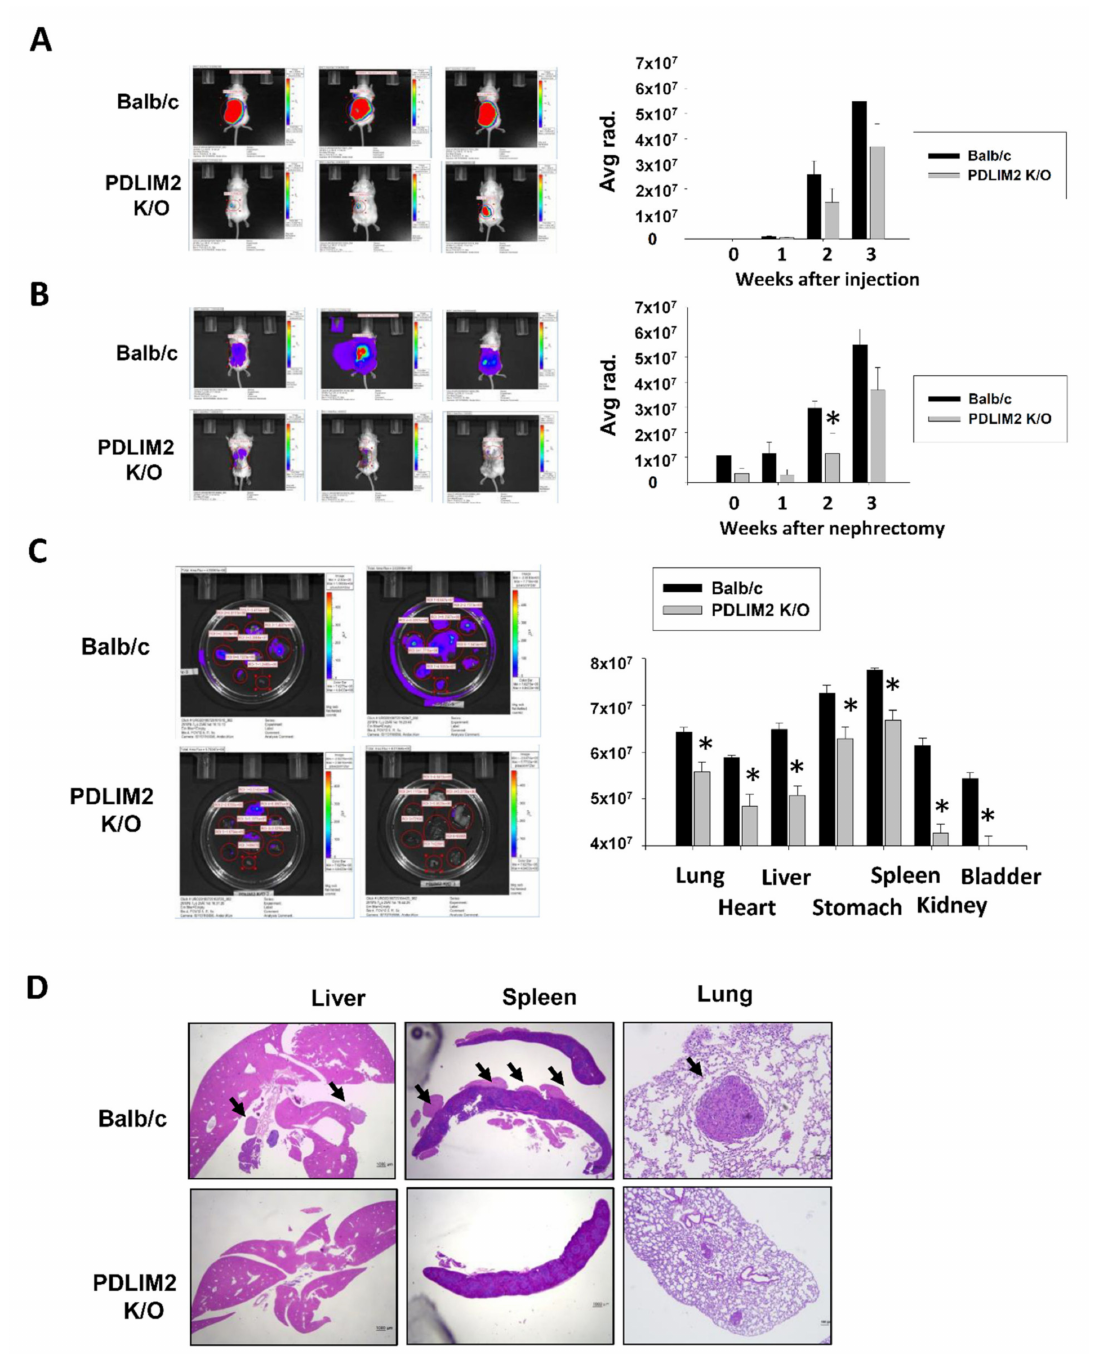
Figure 7. PDLIM2 knockout mice showed metastatic tumors in kidney orthotopic injected model of RenCa murine kidney cancer cells. ( A ) Bioluminescent images from the indicated mice at the day of nephrectomy. Time dependent bioluminescent flux plot quantifying tumors are graphed left. Error bars represent means ± SEM of each group ( n = 10). * p < 0.05 (Student’s t -test) versus the control Balb/c group. ( B ) Bioluminescent images from the indicated mice at the day of sacrifice. Time dependent bioluminescent flux plot quantifying tumors are graphed left. Error bars represent means ± SEM of each group ( n = 10). * p < 0.05 (Student’s t -test) versus the control Balb/c group. ( C ) Bioluminescent images from the indicated mice organ at the day of sacrifice. Average bioluminescent flux plot quantifying each tumors are graphed left. Error bars represent means ± SEM of each group ( n = 10). * p < 0.05 (Student’s t -test) versus the control Balb/c group. ( D ) Representative hematoxylin-eosin staining images of the metastasis tumors from indicated mice. Arrow indicates tumor